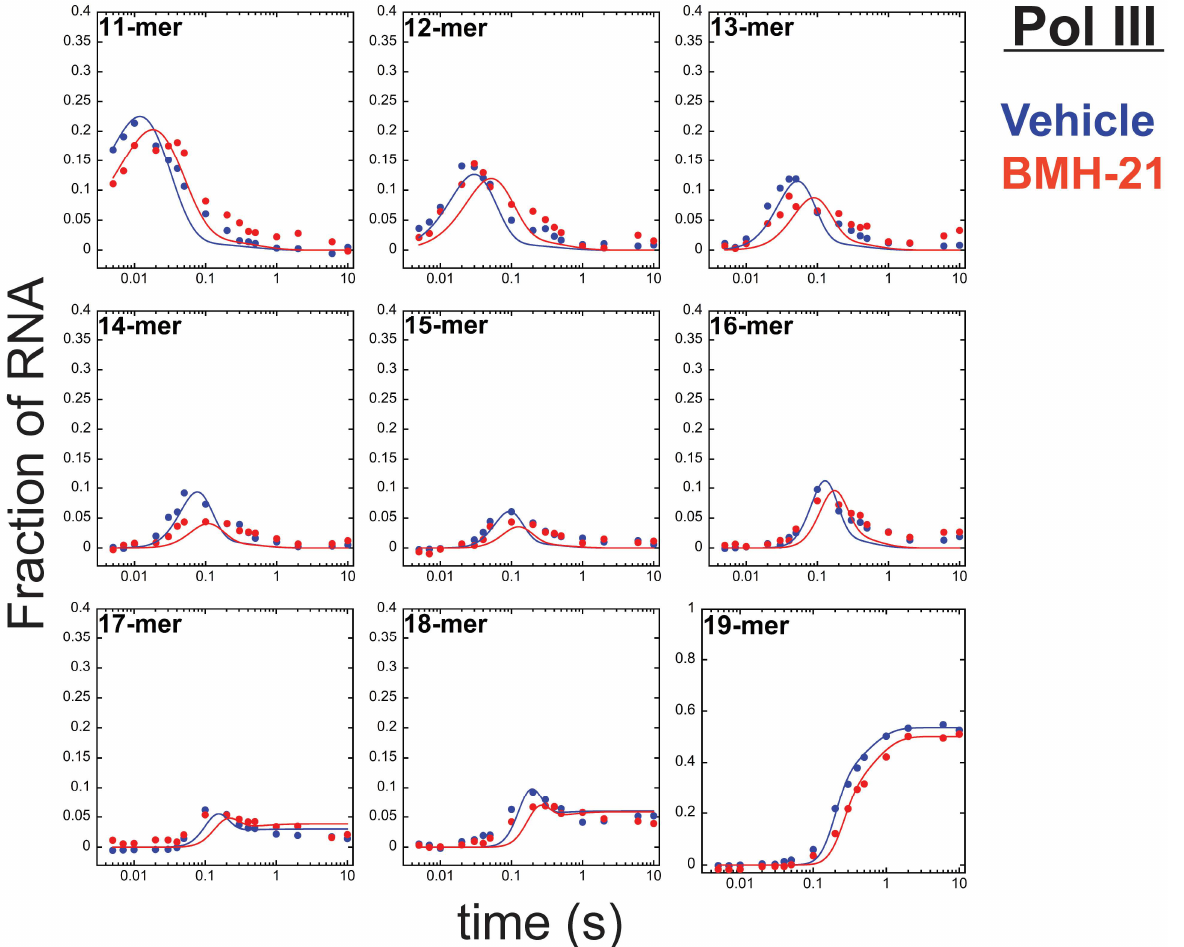
Figure 4. Pol III multi-nucleotide addition in the presence of vehicle or BMH-21. Representative data sets of the fraction of each RNA species over time fit to Scheme 4. Table 3. Resultant parameter values from Pol III vehicle- and BMH-21-treated multi-nucleotide time courses.